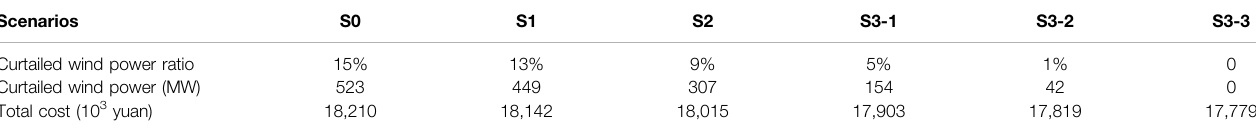
TABLE 4 | The curtailed wind power and costs of different